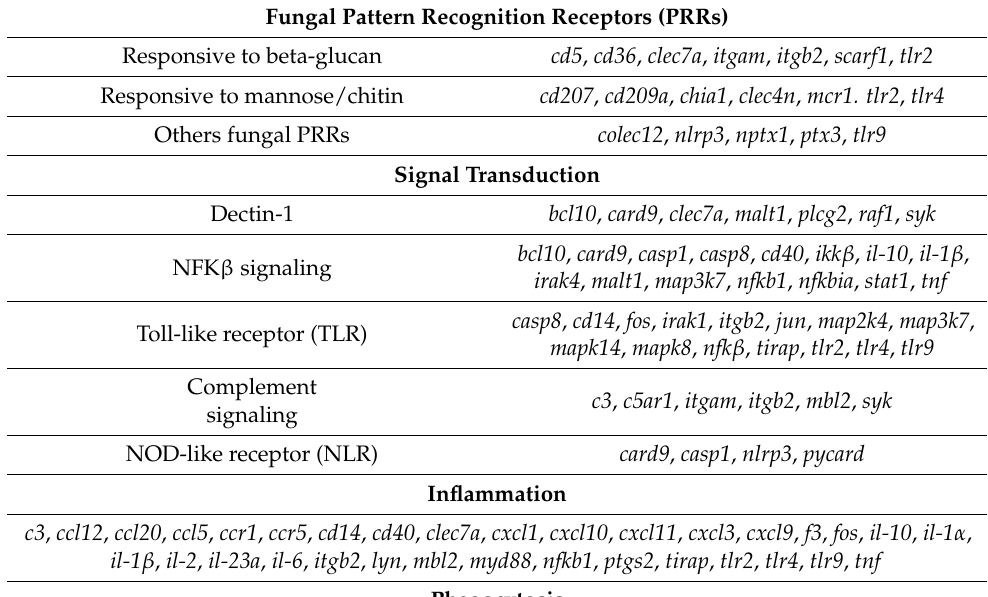
Table 1. RT 2 Profiler PCR Array Mouse Antifungal Response (Qiagen Cat#